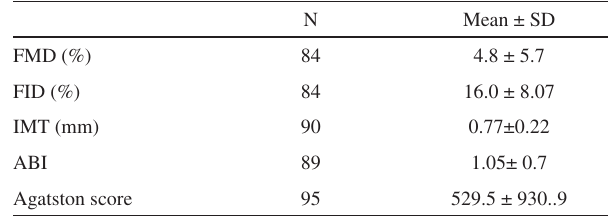
Table 1- Clinical characteristics of patients